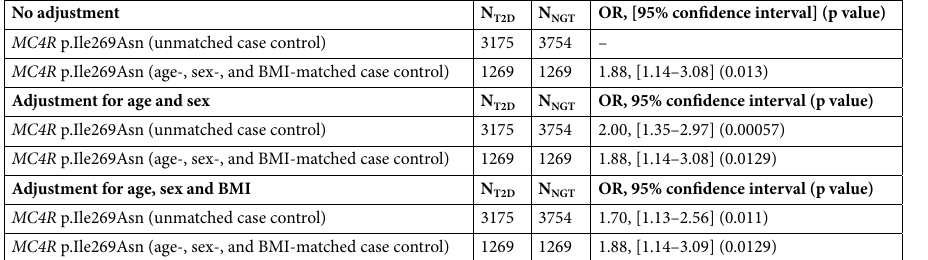
Table 2. Association between the MC4R p.Ile269Asn mutation and type 2 diabetes in Mexican adults using conventional and matched case–control study designs. T2D type 2 diabetes, NGT normal glucose tolerance, BMI body mass index, OR